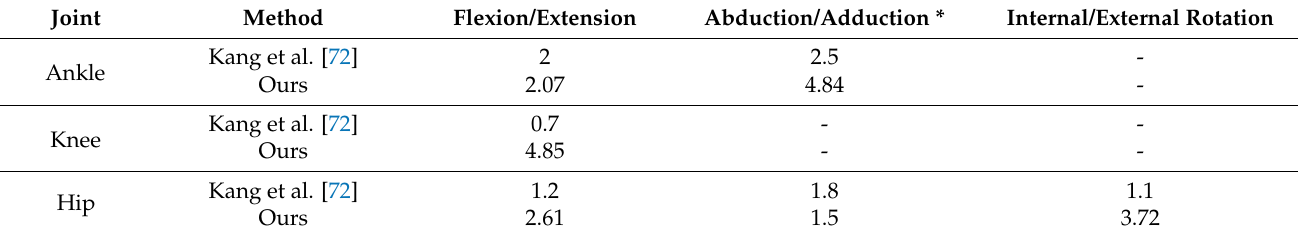
Table 4. Stride-to-stride standard deviations of lower-body angles, with a comparison between the markerless approach of the current study and a marker-based one (averaged over 18 young subjects) [72]. * Ankle subtalar angle is assimilated to an abduction/adduction